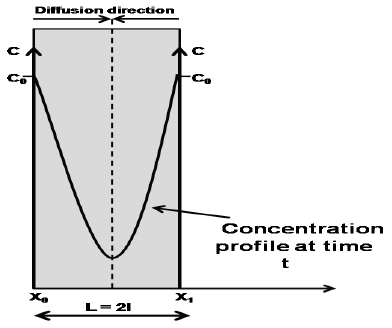
Figure 1. Schematic representation of the concentration profile of penetrant during its diffusion process between two boundaries.